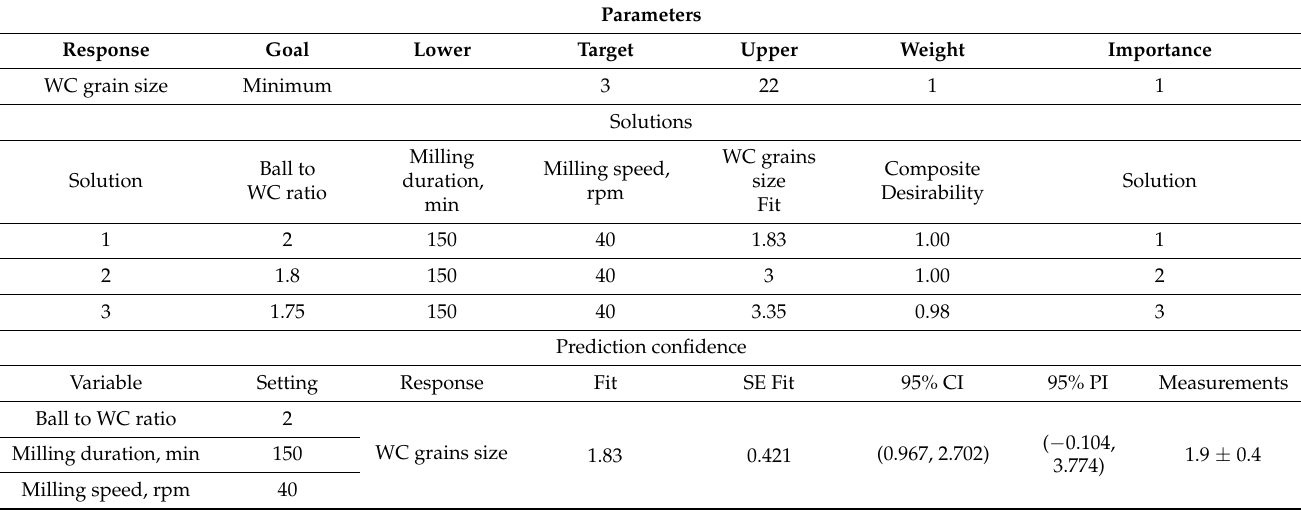
Table 4. Response optimization for WC ball milling after carbidization. SE—standard error, CI— confidence interval, PI—prediction interval.